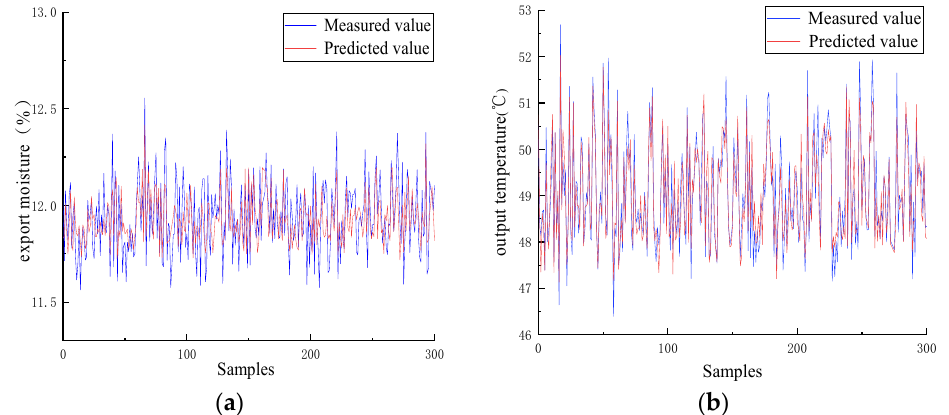
Figure 6. Predicted values of the RBF model on the test set: ( a ) moisture content and ( b ) tempera- ture.